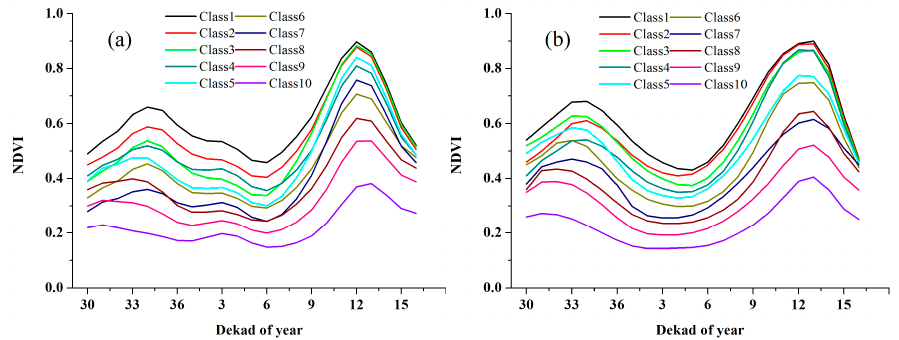
Figure 6. The NDVI profiles of the 10 classes: ( a ) Profiles of the predicted data at Site 1; and ( b ) Profiles of the predicted data at Site 2.